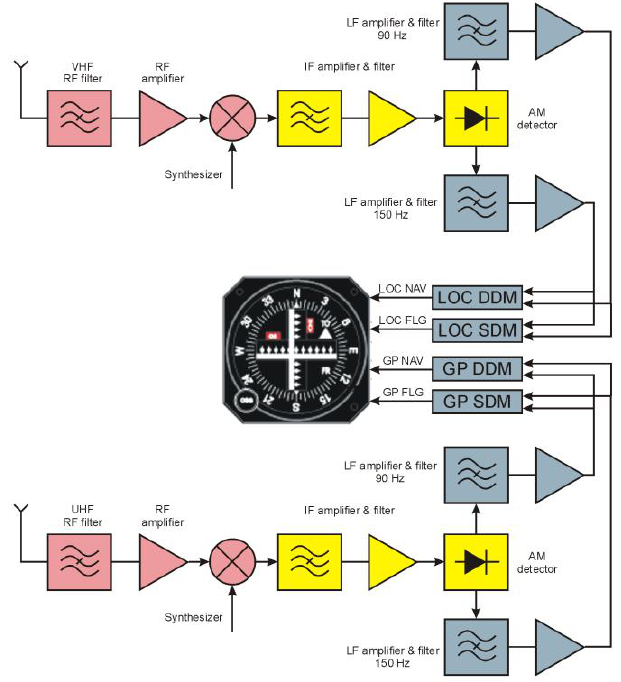
Figure 9. Instrument landing system (ILS) receiver block diagram.